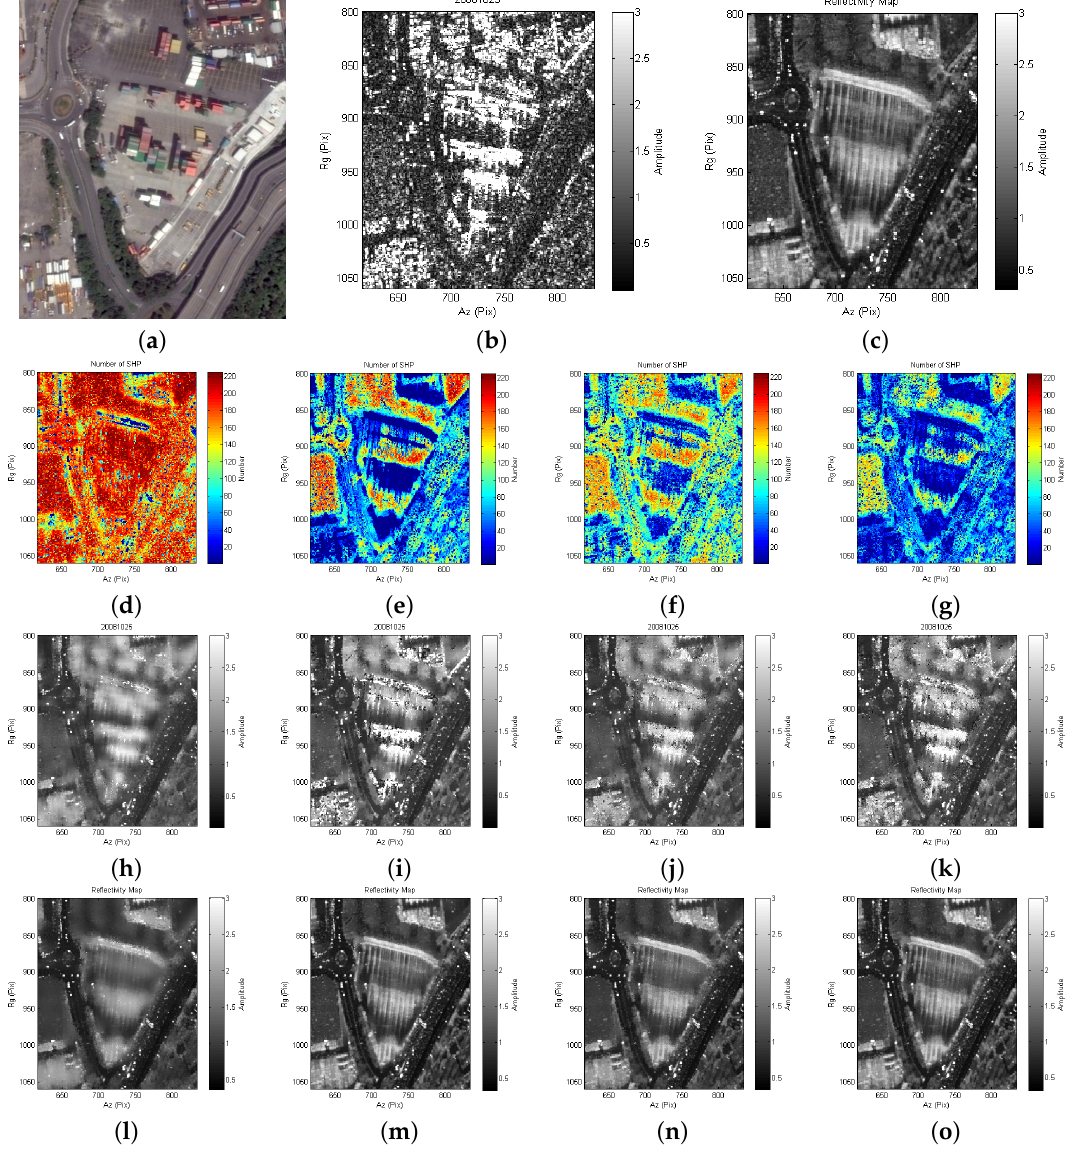
Figure 10. Amplitude denoising of Area 2 based on different approaches and stack sizes. ( a ) an optical image retrieved from Google Earth; ( b ) an unfiltered amplitude map acquired on 25 October 2008; ( c ) a reflectivity map generated by the original data stack (75 images); ( d – g ) SHP number corresponds to AD 10 imgs , AD 75 imgs , TR 10 imgs , and TR 75 imgs , respectively; ( h – k ) denoised amplitude maps correspond to AD 10 imgs , AD 75 imgs , TR 10 imgs , and TR 75 imgs , respectively; and ( l – o ) denoised reflectivity maps correspond to AD 10 imgs , AD 75 imgs , TR 10 imgs , and TR 75 imgs ,